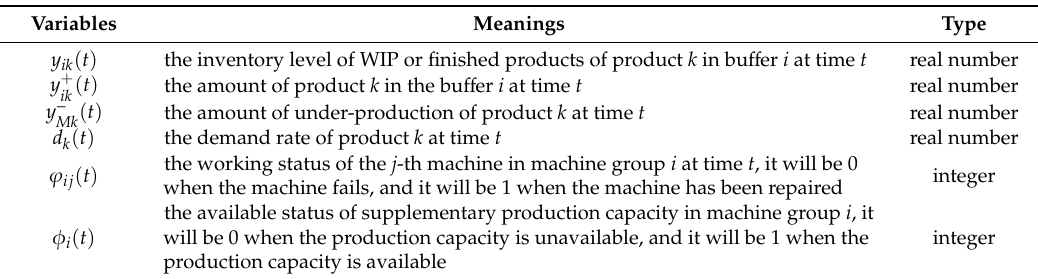
Table 2. The system variables in the manufacturing system.